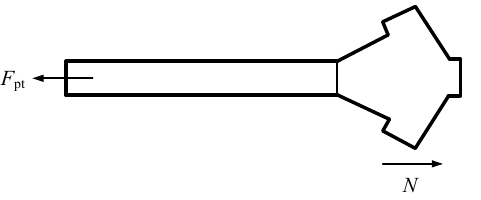
Figure 9. Force analysis of recoil part.